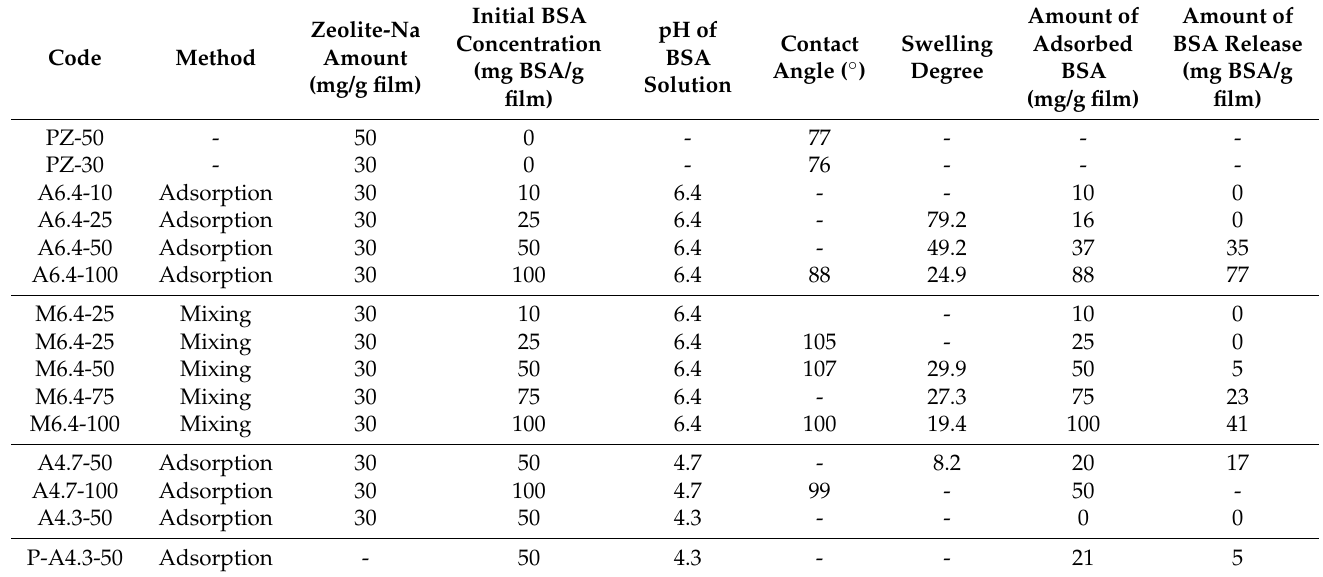
Table 1. Synthesis conditions, contact angle, swelling degree, and amounts of adsorbed and released BSA from the pectin-based